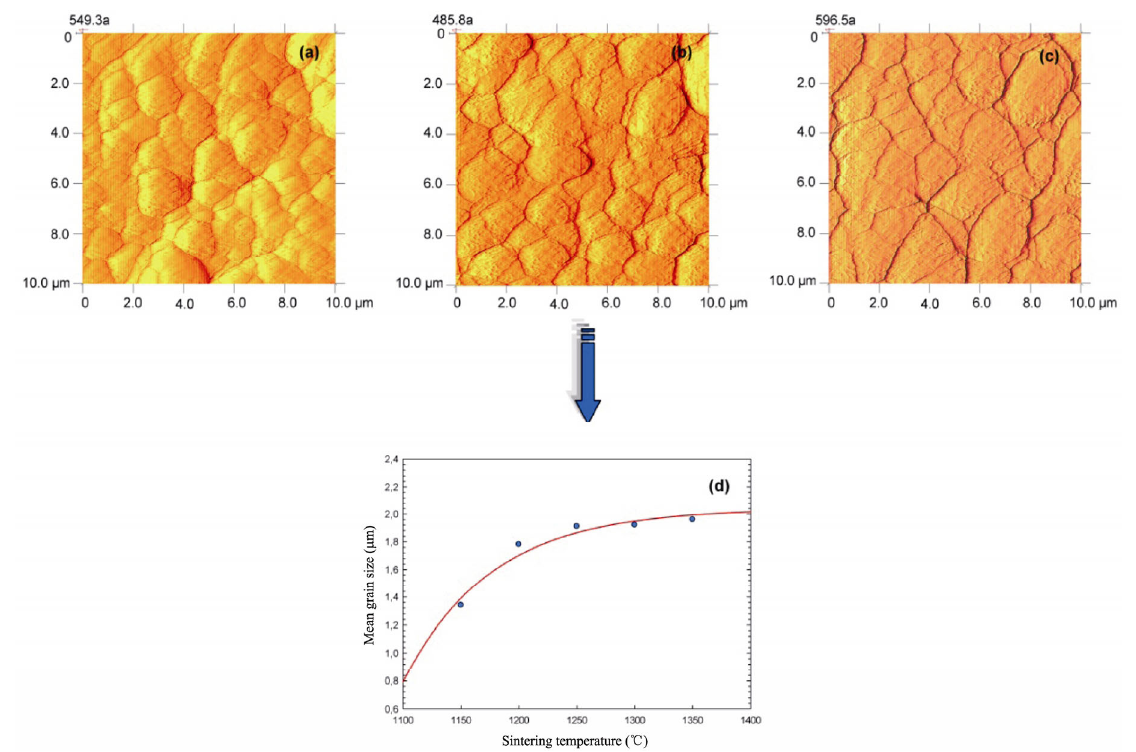
Fig. 11 AFM images of the samples sintered at (a) 1150, (b) 1200, (c) 1350 ℃ and (d) mean grain size variation as a function of sintering temperature.